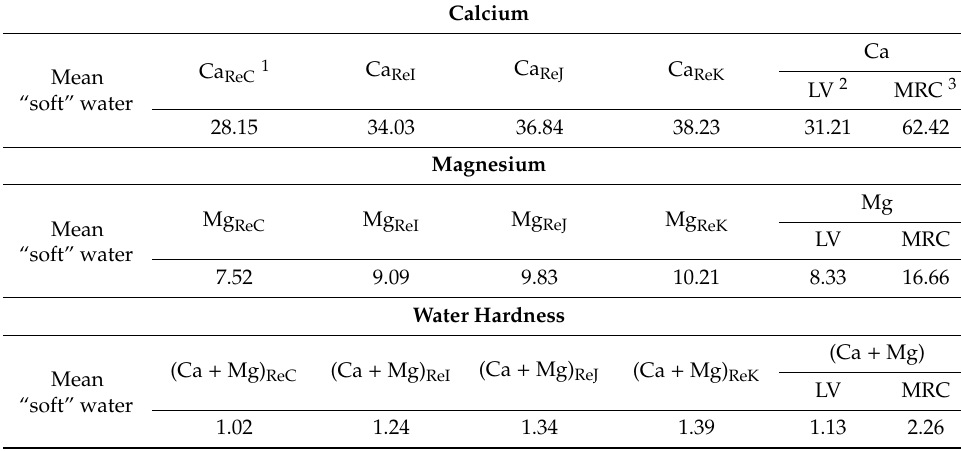
Table 4. Limit and minimum required Ca and Mg contents and water hardness (Ca + Mg) in drinking water derived from health indicators (ReC, ReI, ReJ and ReK) of the “soft” water group and national average for “soft” water